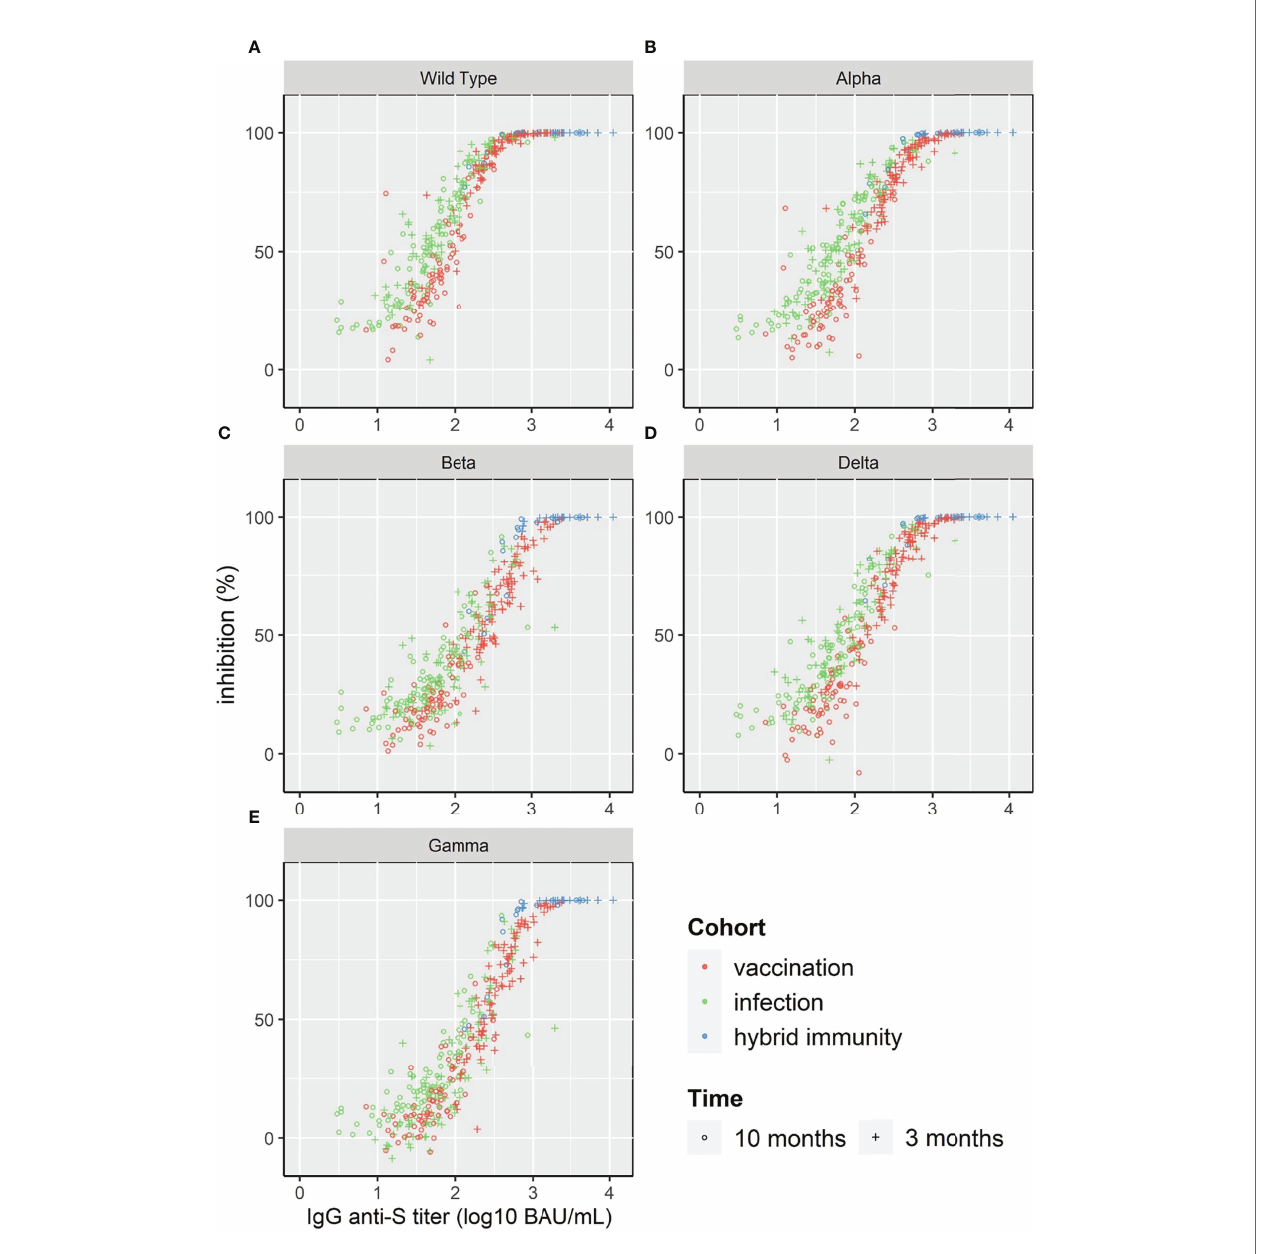
FIGURE 4 | Scatterplot of surrogate neutralizing antibody inhibition levels (%) and IgG anti-S for WT and 4 VOC (A – E)